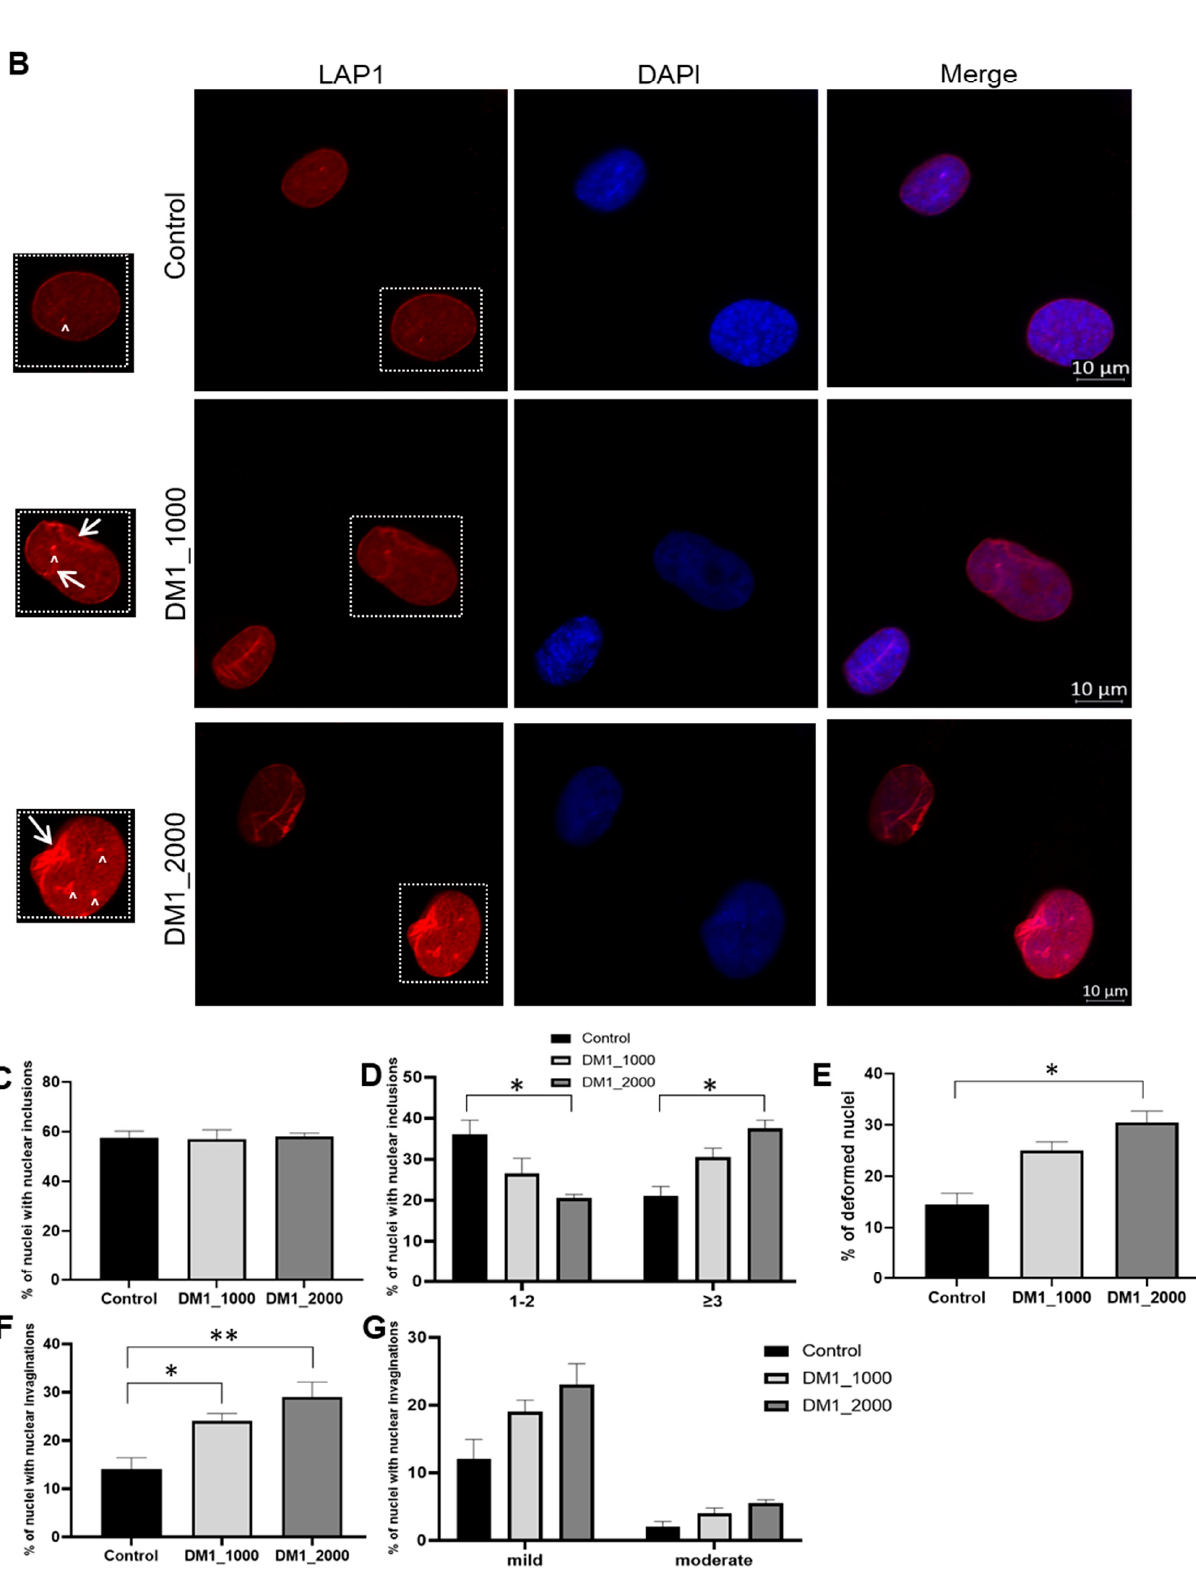
Figure 5. Intracellular protein levels and nuclear localization of LAP1 in DM1 patient-derived and control fibroblasts. ( A ) Total LAP1, LAP1B and LAP1C intracellular protein levels in DM1 patient- derived and control fibroblasts. The intracellular protein levels in DM1 patient-derived fibroblasts were estimated in relation to protein levels detected in the control condition and are presented